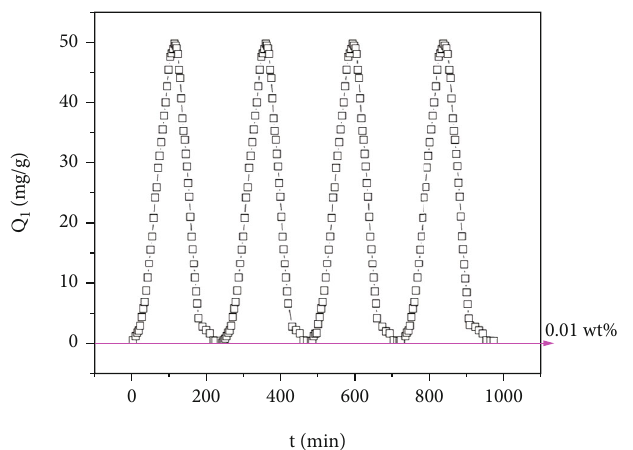
Figure 10: Volumetric recycle runs of CO